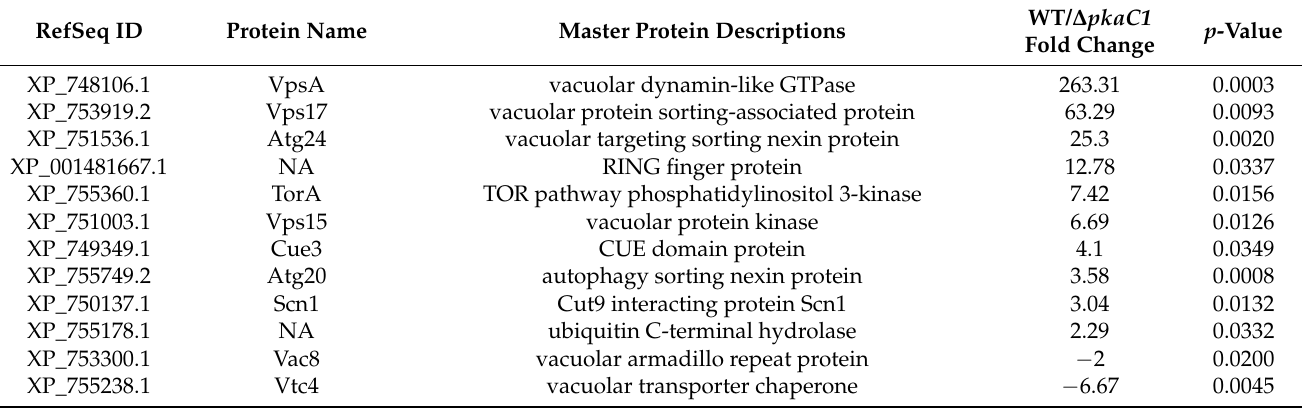
Table 2. Likely autophagy-associated proteins exhibiting PKA-dependent